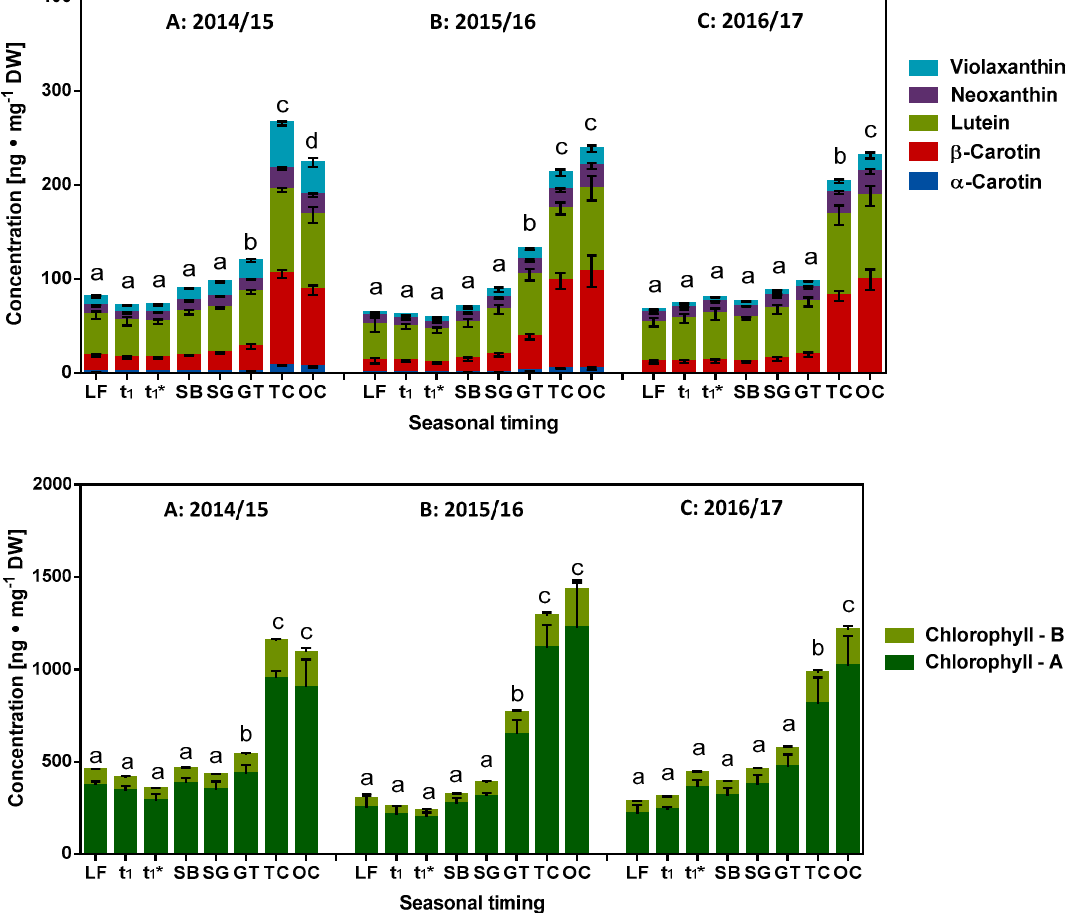
Figure 6. Composition of the main carotenoids and chlorophylls during the different milestones of the development stages as determined by HPLC. ( A ) Season 2014/15; ( B ) Season 2015/16 and ( C ) Season 2016/17. Abbreviations: LF, leaf fall; t 1 = endodormancy release, t 1 * = beginning of ontogenetic development, SB = swollen bud, SG = side green, GT = green tip, TC = tight cluster, OC = open cluster; DW, dry weight. Different small letters in each season (a–d) indicate significantly different mean values of the total carotenoid/chlorophylls from the previous or subsequent values (Tukey's multiple comparisons test, p ≤ 0.05, n = 4) for each milestone.